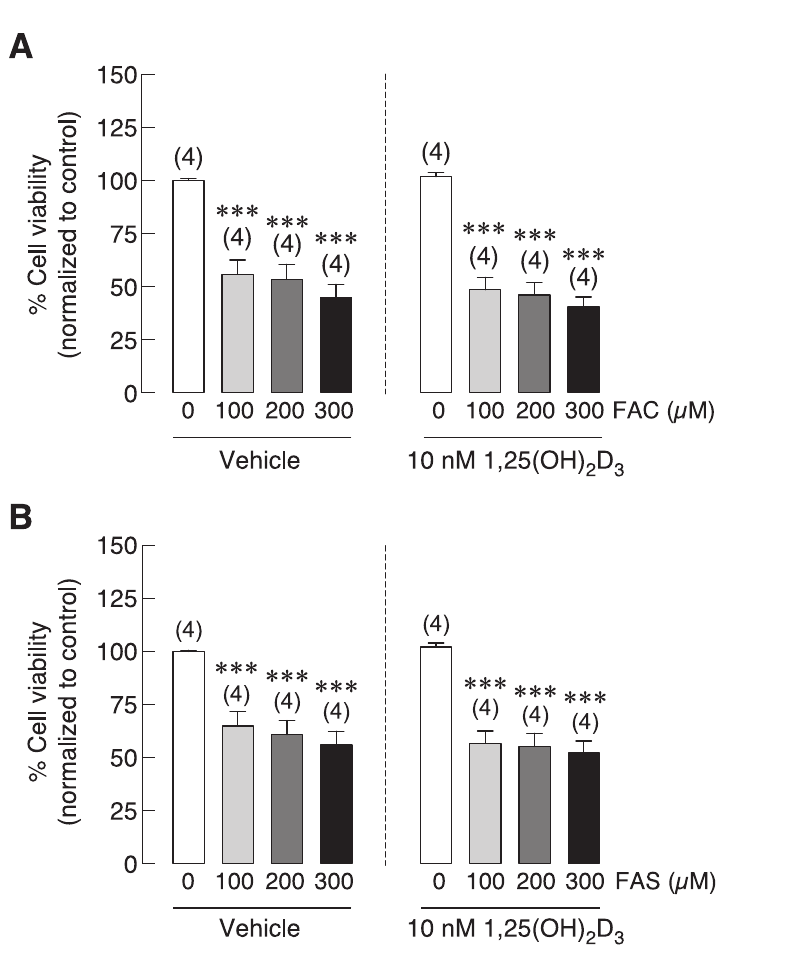
Fig 4. UMR-106 osteoblast cell viability was tested under the presence of (A) FAC or (B) FAS together with vehicle control or 1,25(OH) 2 D 3 . 1,25(OH) 2 D 3 did not significantly affect osteoblast cell viability under iron overload with FAC and FAS. ��� P < 0.001 as compared to control group (0 μ M) with vehicle control.